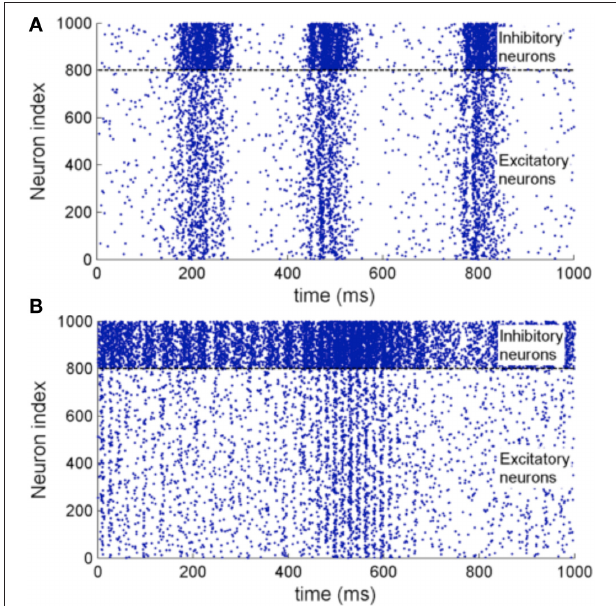
FIGURE 11 | (A) Raster plot of the network activity with 1000 neurons at the beginning of the simulation. (B) Raster plot of the same set of neurons after a 3600s simulation with STDP enabled. It shows oscillations of 2–4Hz before the simulation and 30–100Hz after the simulation which is of close resemblance of the original